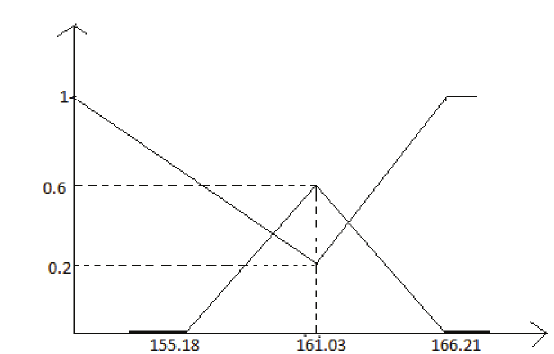
Fig.1: The exact solution of intuitionistic fuzzy matrix game for the market share problem of company